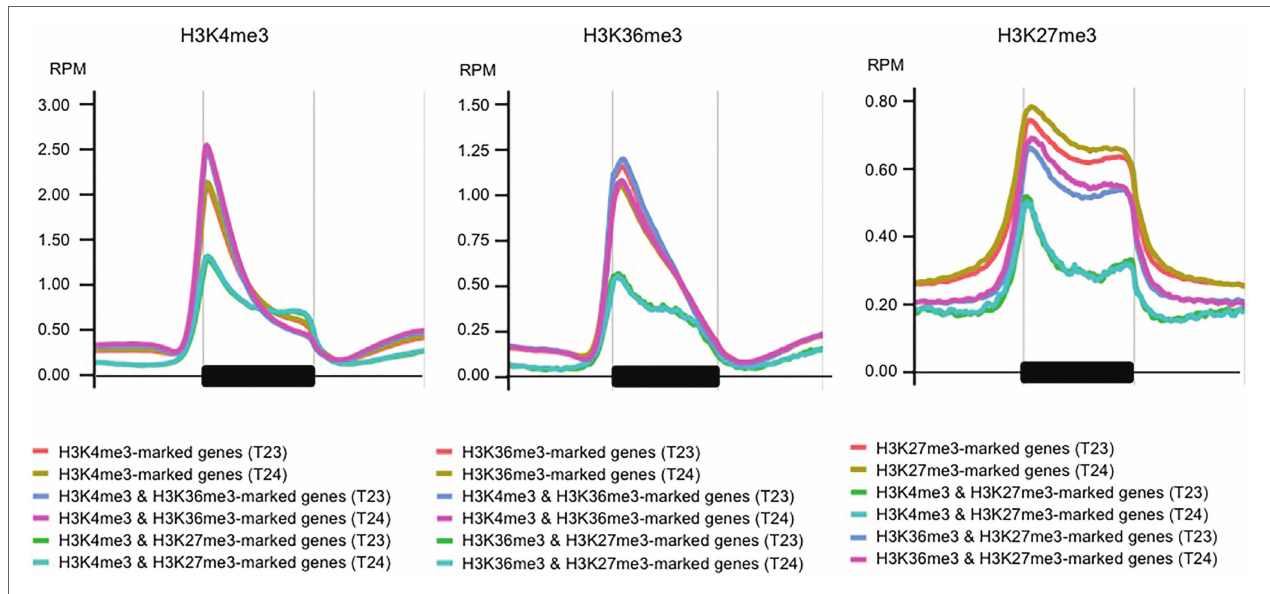
FIGURE 2 | Metagene plots of H3K4me3, H3K36me3, and H3K27me3 in genic regions. H3K4me3 (left panel) , H3K36me3 (middle panel) , and H3K27me3 (right panel) levels at the genic region with 1 kb upstream and 1 kb downstream are shown using genes having one or two histone